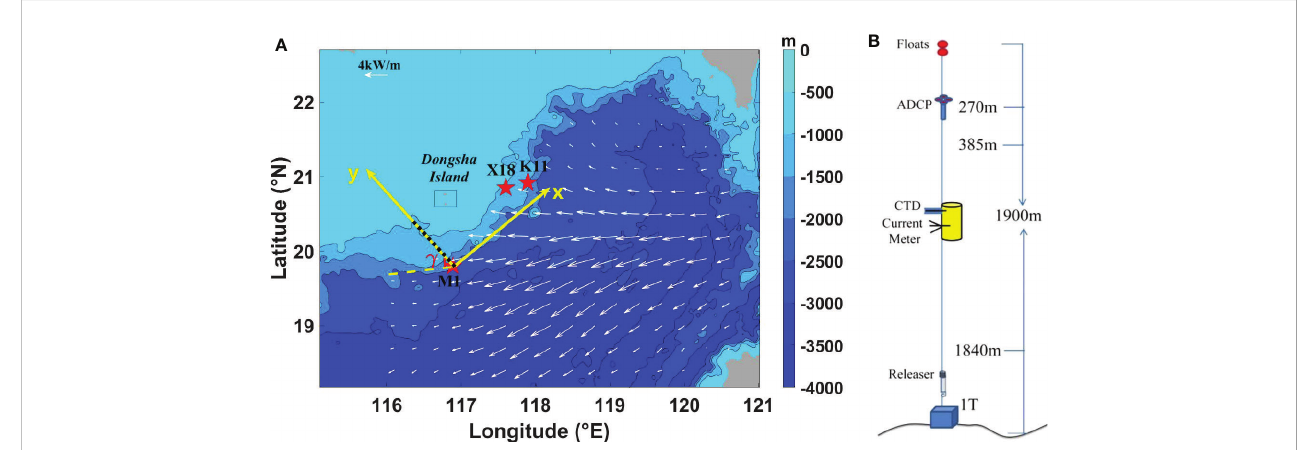
FIGURE 1 (A) The map showing bathymetry and mooring sites (stars) in the northeastern SCS. The axis x and y represent the along-slope and cross-slope directions at M1. The yellow dashed line shows the incident direction of diurnal internal tides near the M1 site, producing an incline angle g with respect to the y -axis. The black dotted line indicates the cross-slope section crossing M1, shown in Figure 2B. The white arrows are the energy fl uxes of K 1 diurnal internal tides from satellite altimeter observations (Zhao, 2014). The X18 and K11 are mooring sites in Xie et al. (2018) and Klymak et al. (2011), respectively. (B) Schematic diagram of the M1 mooring.